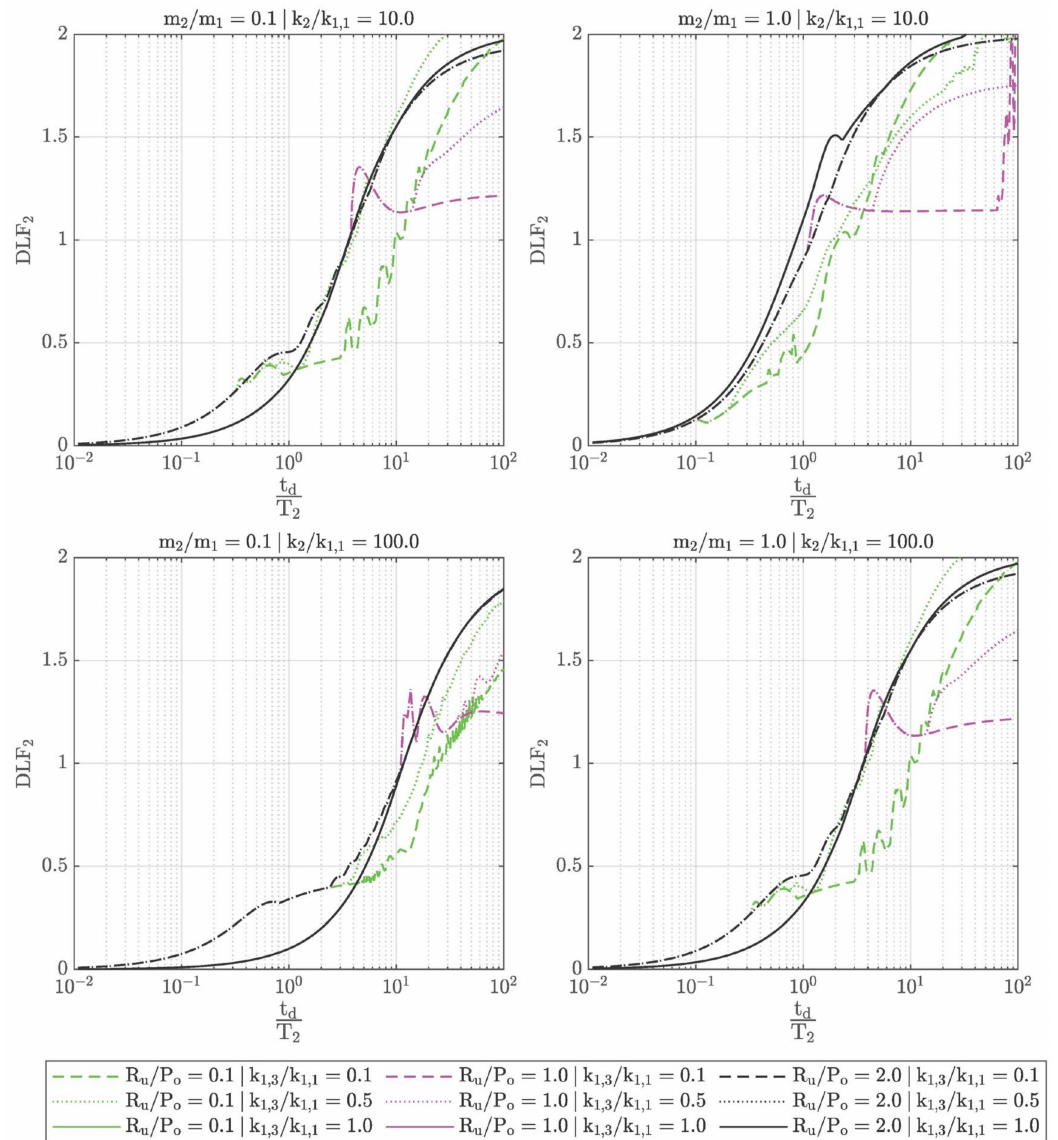
Figure 4. DLF 2 of supporting structure for typical mass, bending stiffness, and membrane stiffness arrangements ( m 2 / m 1 = 0.1, 1.0, k 2 / k 1,1 = 10.0, 100.0, and k 1,3 / k 1,1 = 0.1, 0.5, 1.0) at resistance ratios R u /P o = 0.1, 1.0,